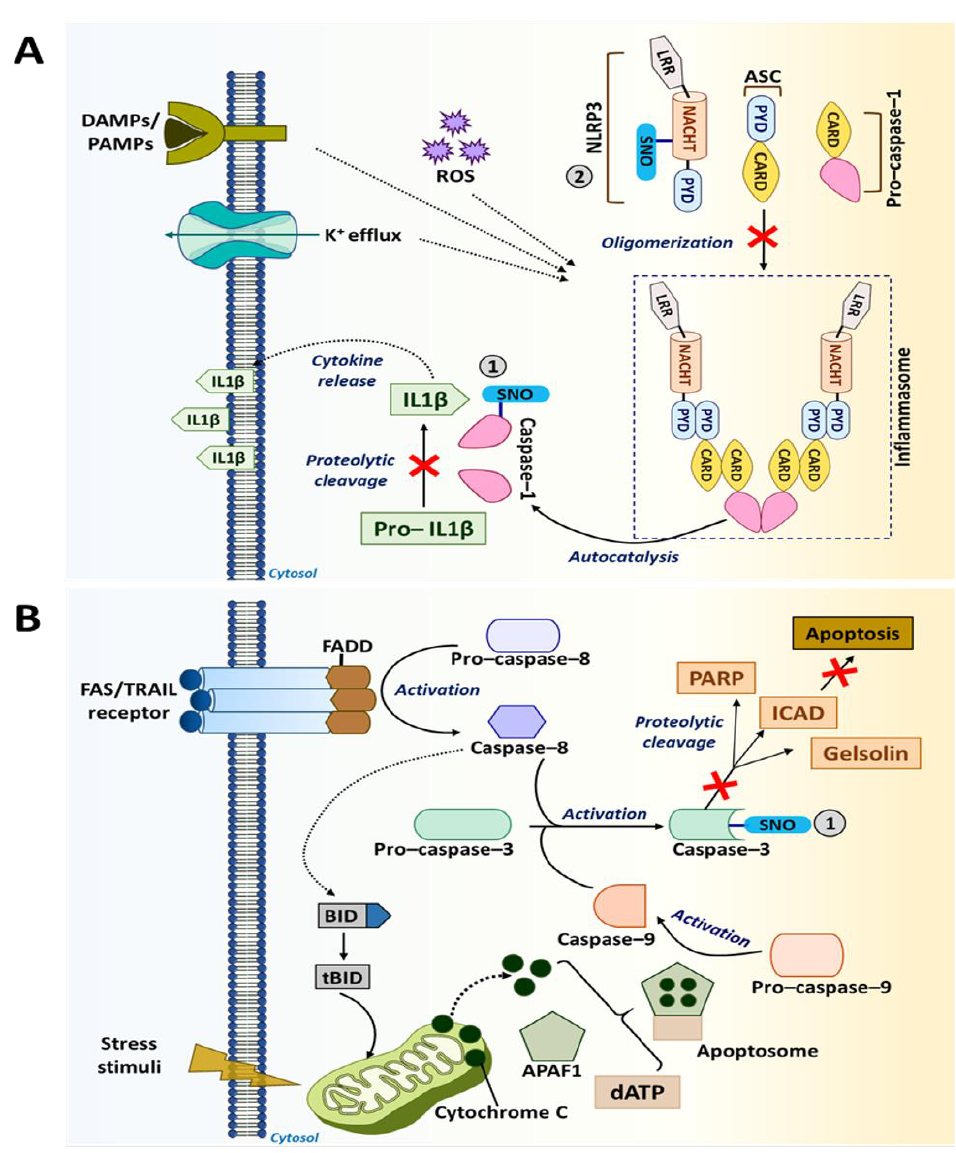
Figure 4. S-nitrosylation in caspase pathways. ( A ) Caspase-1 promotes the maturation and secretion of pro-inflammatory cytokines, such as IL-1 β mediating immune response. However, S-nitrosylation of caspase-1 at Cys285 inhibits the maturation and secretion of IL-1 β . NLRP3 inflammasome helps in the activation of caspase-1. Additionally, NLRP3 also undergoes S-nitrosylation and becomes inactive. ( B ) Cell death receptors, such as Fas/TNF-related apoptosis-inducing ligand [TRAIL], activate caspase-3-mediated apoptotic signaling in the presence of caspase-8 and caspase-9. How- ever, S-nitrosylation of caspase-3 at the catalytic site cysteine (Cys163) causes the inhibition of its apoptotic